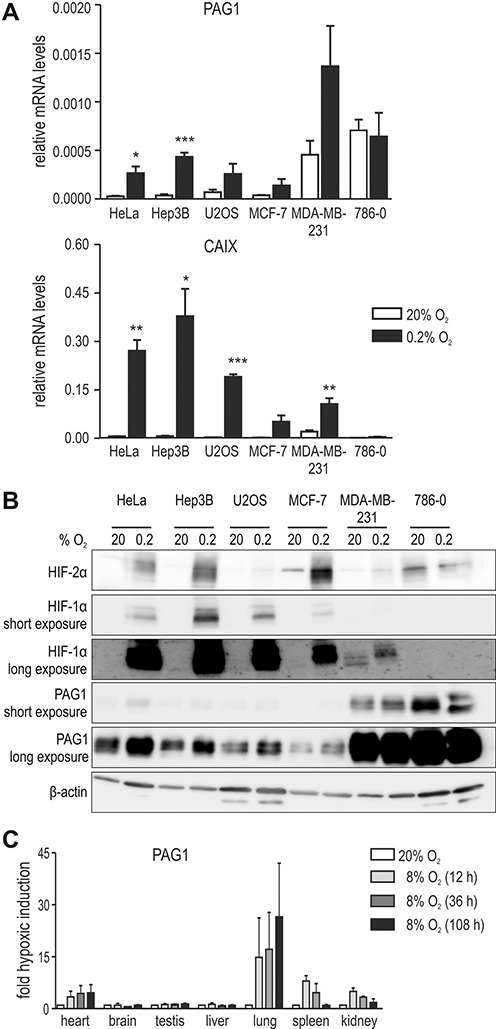
Oxygen-regulated PAG1 expression in vitro and in vivo. (A) The indicated cancer cell lines were exposed to 20% or 0.2% O2 for 24 h and mRNA levels of PAG1 (top panel) and CAIX (bottom panel) were determined by RT-qPCR. Results of at least three independent experiments are shown relative to β-actin control mRNA levels. Error bars correspond to the SEM and statistical analyses were performed with an unpaired Student's t-test (*P < 0.05; **P < 0.01; ***P < 0.001). (B) Cells were treated as in (A) and protein levels of HIF-2α, HIF-1α, PAG1 and β-actin were determined by immunoblotting. (C) Groups of three C57Bl/6 mice were exposed to inspiratory hypoxia (8% O2) for 12–108 h. PAG1 mRNA levels in the organs indicated were determined by RT-qPCR and normalised to ribosomal protein S12 mRNA levels. Results are displayed as fold hypoxic induction, error bars correspond to the SEM.